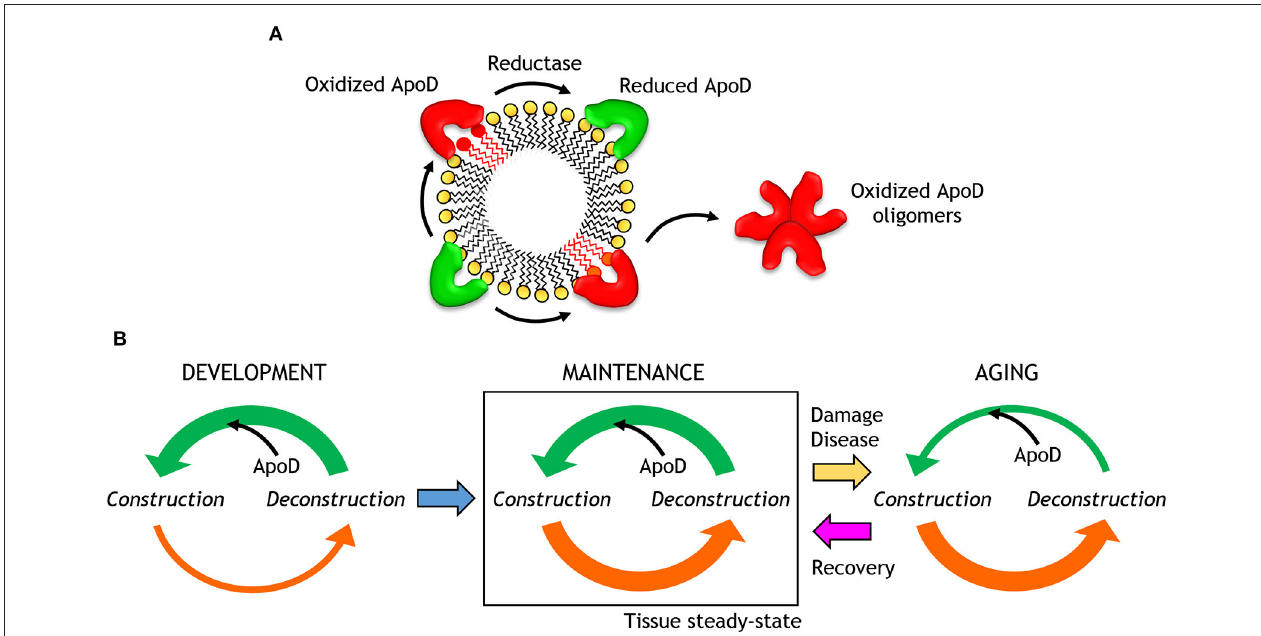
FIGURE 7 | ApoD physiology summary. (A) Schematic view of the lipid-managing biochemical function of ApoD. The lipid structure depicted can equally represent the surface of a lipoprotein particle, extracellular vesicle or cellular membrane. ApoD antioxidant activity can be maintained by redox cycling, requiring a reductase activity, or the cycle can terminate by oligomerization of oxidized ApoD. (B) Summary of global tissue function of ApoD, where it contributes to the turnover and maintenance of tissues and organs. This equilibrium is reached after developmental processes in which ApoD is also involved, and switches to a different state upon disease, injury or physiological